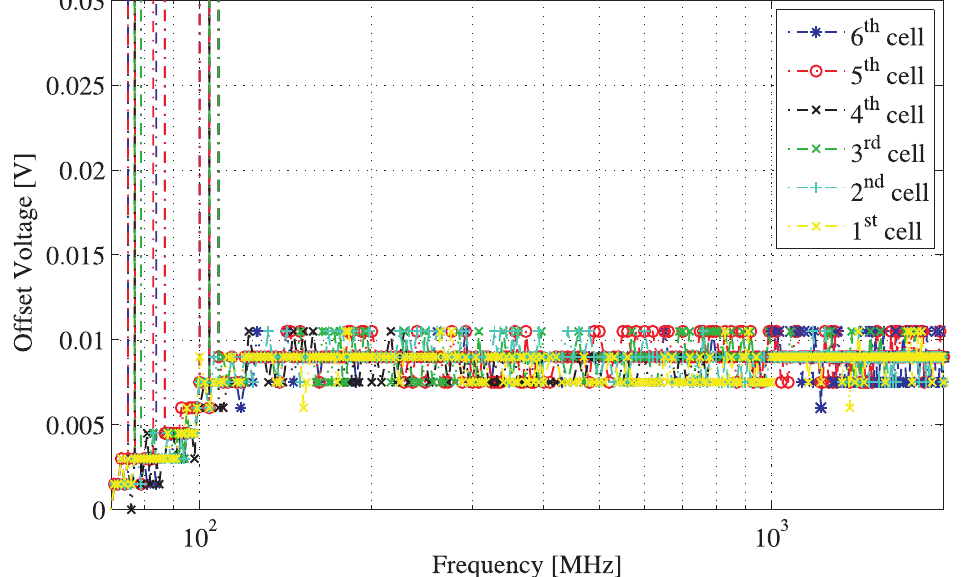
Figure 11. EMI-induced offset in the cell voltage readings obtained in accordance with failure levels of Figure 9 above 50 MHz (simultaneous injection on the four SPI